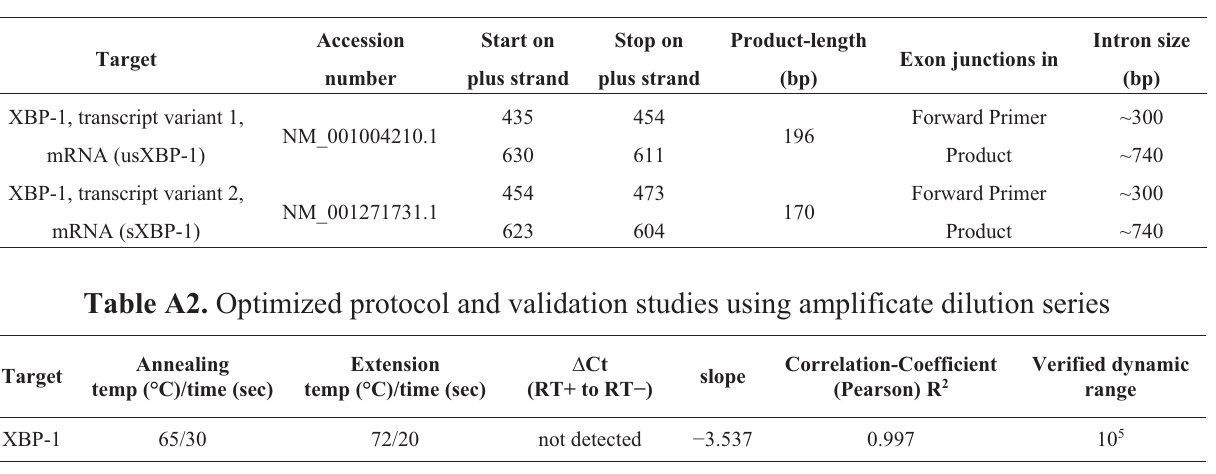
Table A1. Information about Intron-spanning primers.